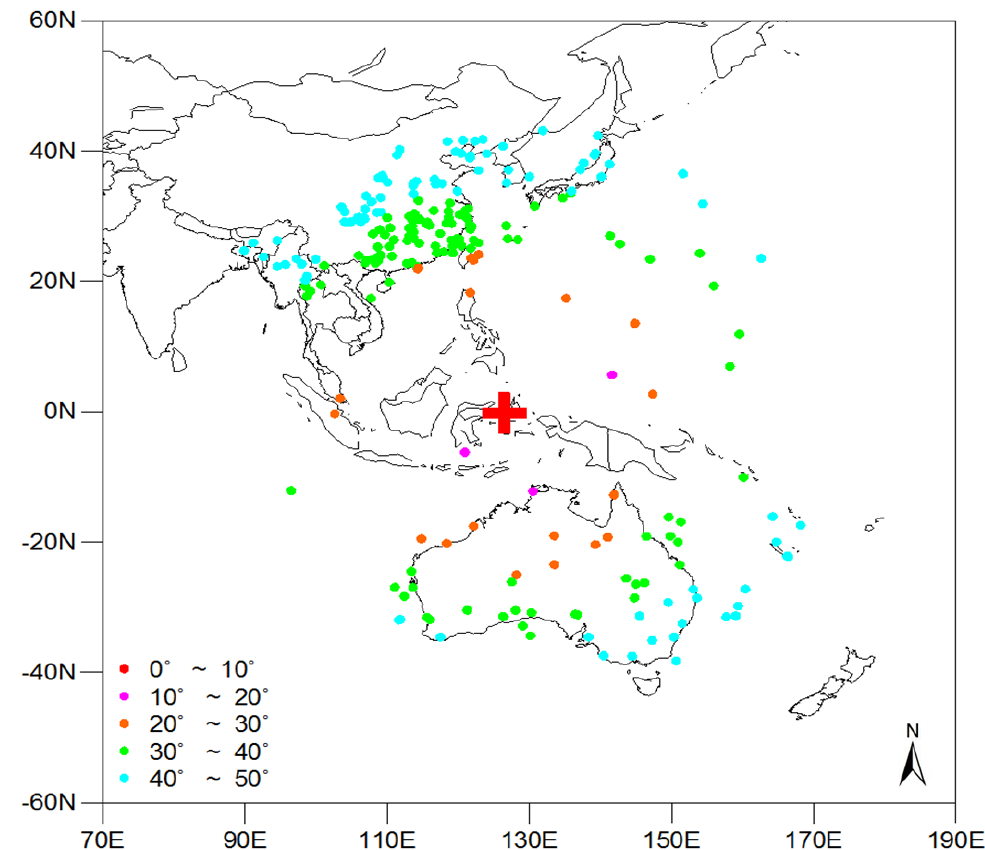
Figure 1. Spatial distribution of Thermodynamic Initial Guess Retrieval (TIGR) data used in this study. The nadir position of COMS is represented by “ 